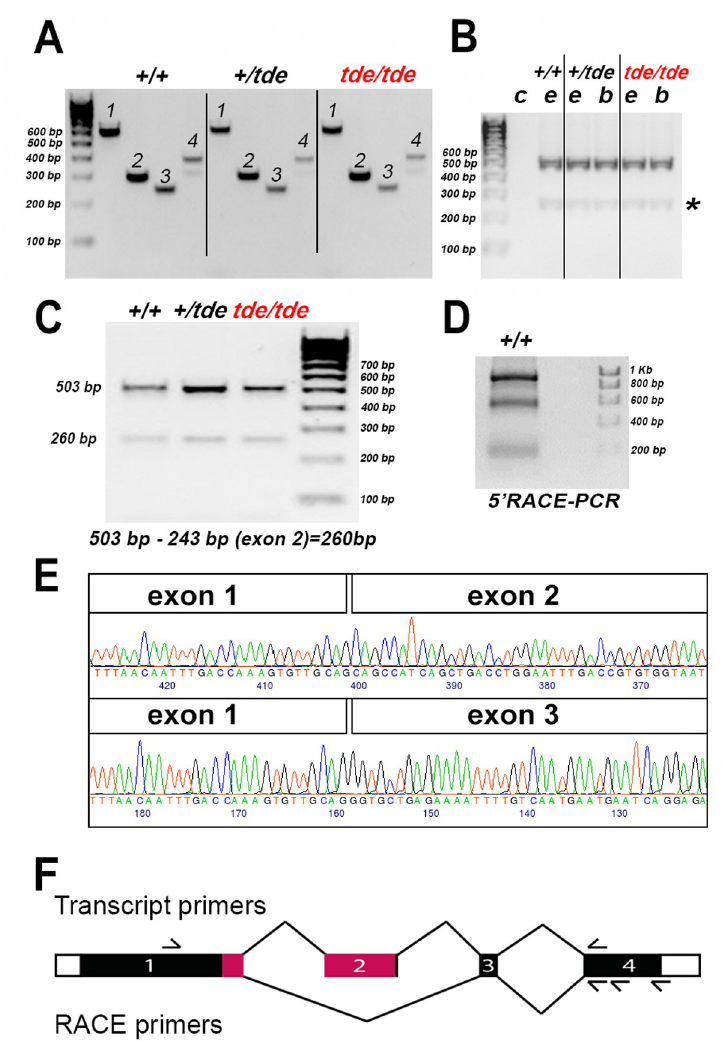
Fig 3. Grxcr1 gene and transcript expression by PCR. A, PCR amplification of genomic DNA from +/+, +/ tde , tde / tde mice with primers specific to each exon of Grxcr1 gene. One single band was amplified for each exon (1–4). Sequencing of all tde genotypes revealed no differences between the genotypes. B , PCR amplification of cDNA derived from the inner ear (e) and brain (b) tissue of +/+, +/ tde and tde / tde adult mice, using primers located in Grxcr1 exons 1 and 4, resulted in two bands. No band was detected in the negative control (c). The second weak band was detected in all tde genotypes (asterisk). C , PCR was performed using cDNA from adult inner ears of all tde genotypes. Two bands were amplified in mutants and control mice. D 5’ RACE-PCR was performed using primers within exon 4 to amplify the entire Grxcr1 transcript from the P6 C57BL/6N wild-type inner ear. The gel shows 2 strong bands of different sizes that were sequenced. E , Partial traces and sequence of the larger band (upper panel) and smaller band (lower panel) amplified in B and C showing part of the Grxcr1 transcript sequence which skips exon 2. F , Schematic of the Grxcr1 gene, not to scale. Protein-coding sequences are shown as filled rectangles, and untranslated sequences as empty rectangles. The exons are numbered, and lines connect them in the two splicing patterns observed, with the canonical pattern on top and the novel pattern below. The approximate positions of the transcript primers are shown above, and the RACE primers below. Pink indicates the location of the glutaredoxin domain (amino acids 127–234, from Uniprot, www.uniprot.org, accessed July 2021). protein would lack most of the glutaredoxin domain so likely has a different function to the full length GRXCR1 (Fig 3F; S1 File). In conclusion, while the transgene insertion causes a considerable reduction of Grxcr1 expression, it does not affect the transcript sequence.